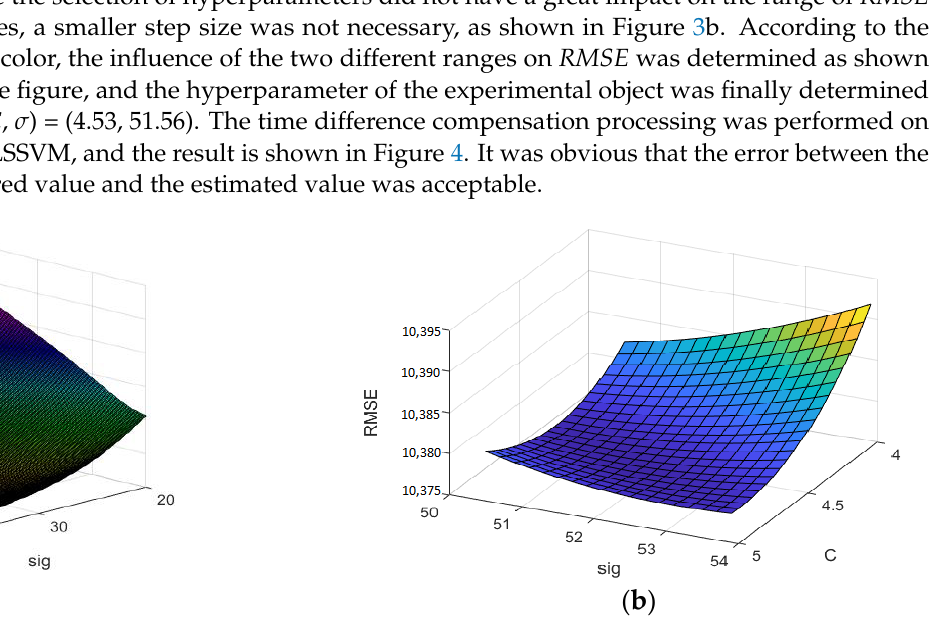
Figure 3. Hyperparameter piece-wise optimization: ( a ) hyperparameter with a small step size and ( b ) hyperparameter with a large step size.